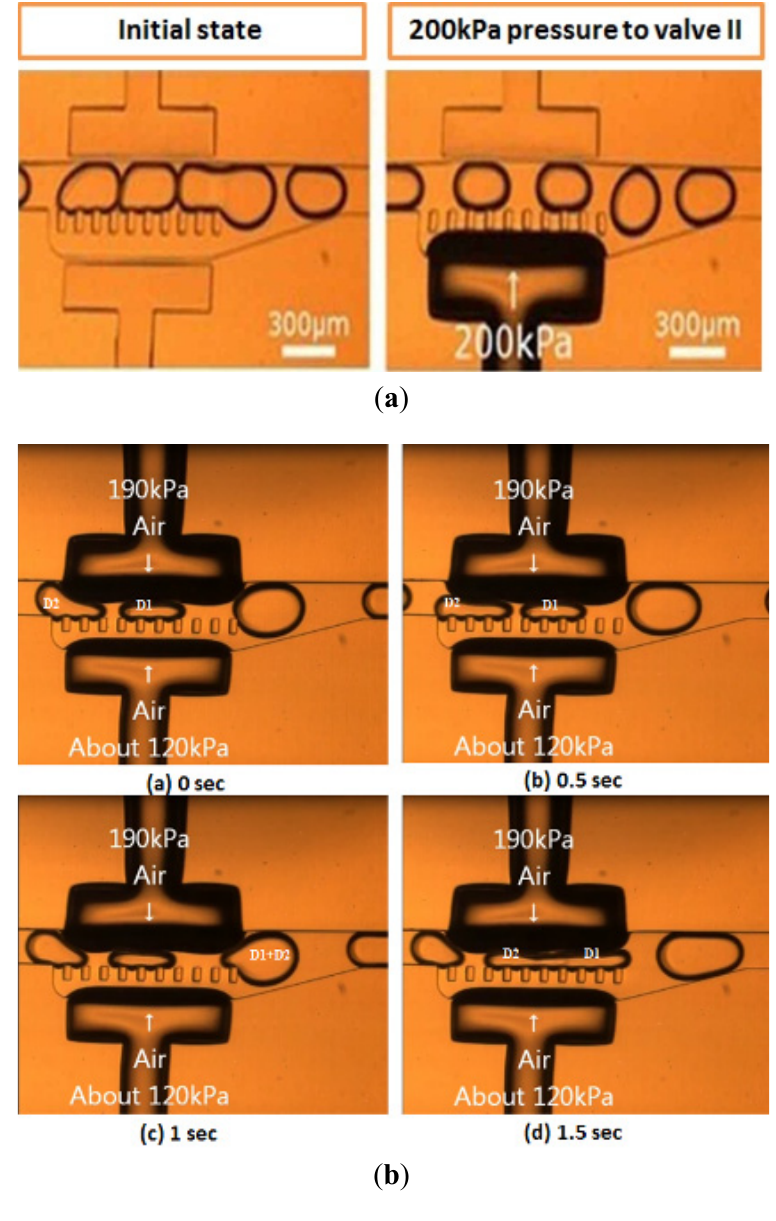
Figure 5. Sequence of images demonstrating the droplets merging process under different pneumatic valve Pressures with time sequence ( a ) initial state of droplets flow in merging chamber before and after applying pressure ( b ) Captured images of two droplets merging ( c ) Captured images of three droplets